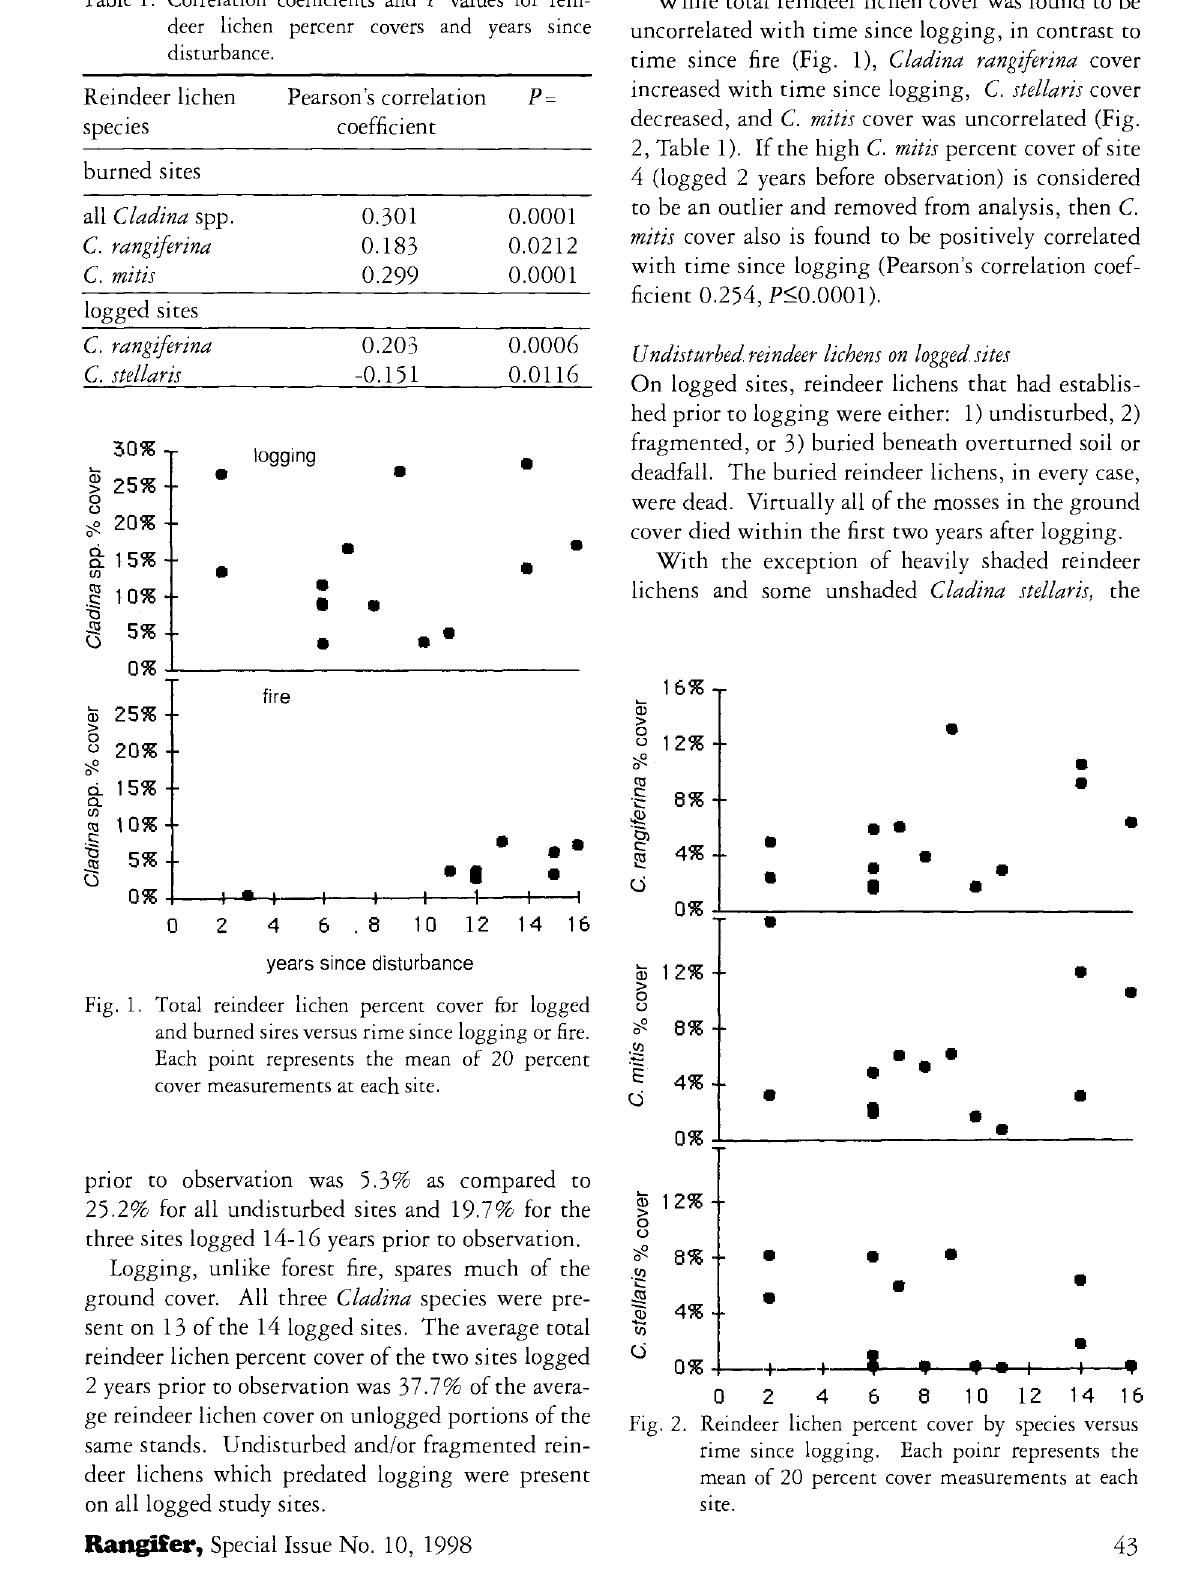
Table 1. Correlation coefficients and P values for rein deer lichen percenr covers and years since disturbance.